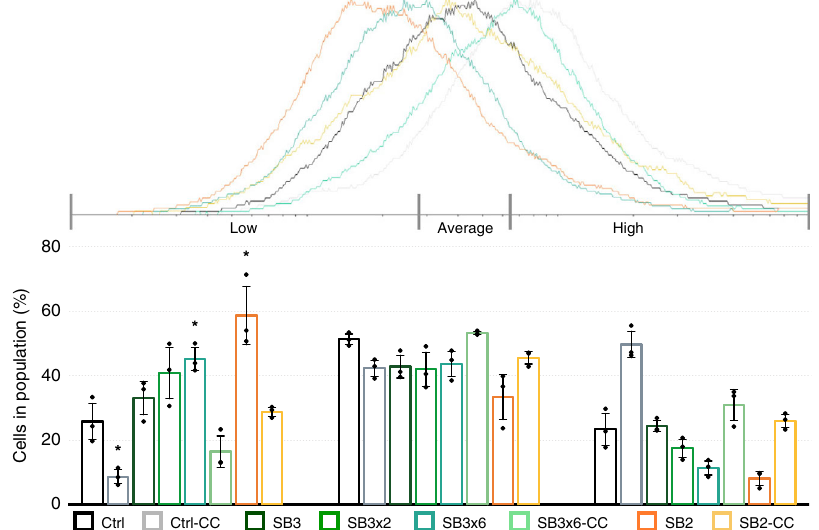
Fig. 4 Surface glycosylation in silenced and control pIZ-plasmid cultures. FC-Histogram ( fl uorescent fl ow cytometry, created with Flowing Software 2.5.1 , 3 biol. repl, n = 10,000 per replicate) of lectin stained (WGA-Alexa488) cultures harvested at OD 600 = 0.1. Bar chart represents percent of cells in population showing low, average or high fl uorescence (normalized to cell size). Sections were de fi ned according to Ctrl histograms. Bars in the graph represent the samples in the following order from left to right (in every section): Control (dark gray); control-CC (light gray); SB3, (dark green); SB3×2 (green); SB3×6 (petrol); SB3×6-CC (light petrol); SB2 (orange); SB2-CC (yellow). Error bars, mean ± SD (three biol. repl.). Asterisks indicate signi fi cant differences to Ctrl (two-tailed t test, n = 3, p ≤ 0.037). Source data are provided